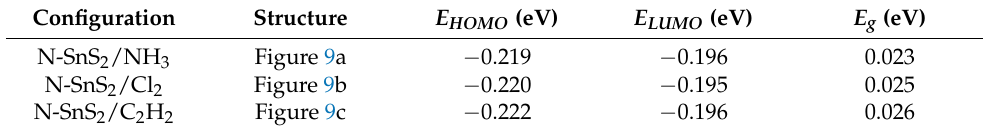
Figure 9. HOMO and LUMO of gas-adsorbed N-SnS 2 systems: ( a ) N-SnS 2 /NH 3 , ( b ) N-SnS 2 /Cl 2 , ( c ) N-SnS 2 /C 2 H 2 . Table 5. Energy of HOMO, LUMO, and energy gap of N-SnS 2 and adsorption